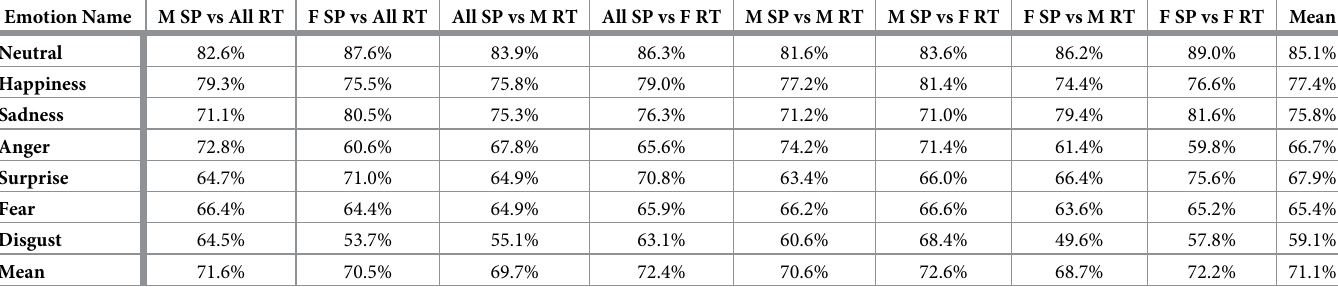
Table 5. Average recognition rates for males and females in Phase 1.